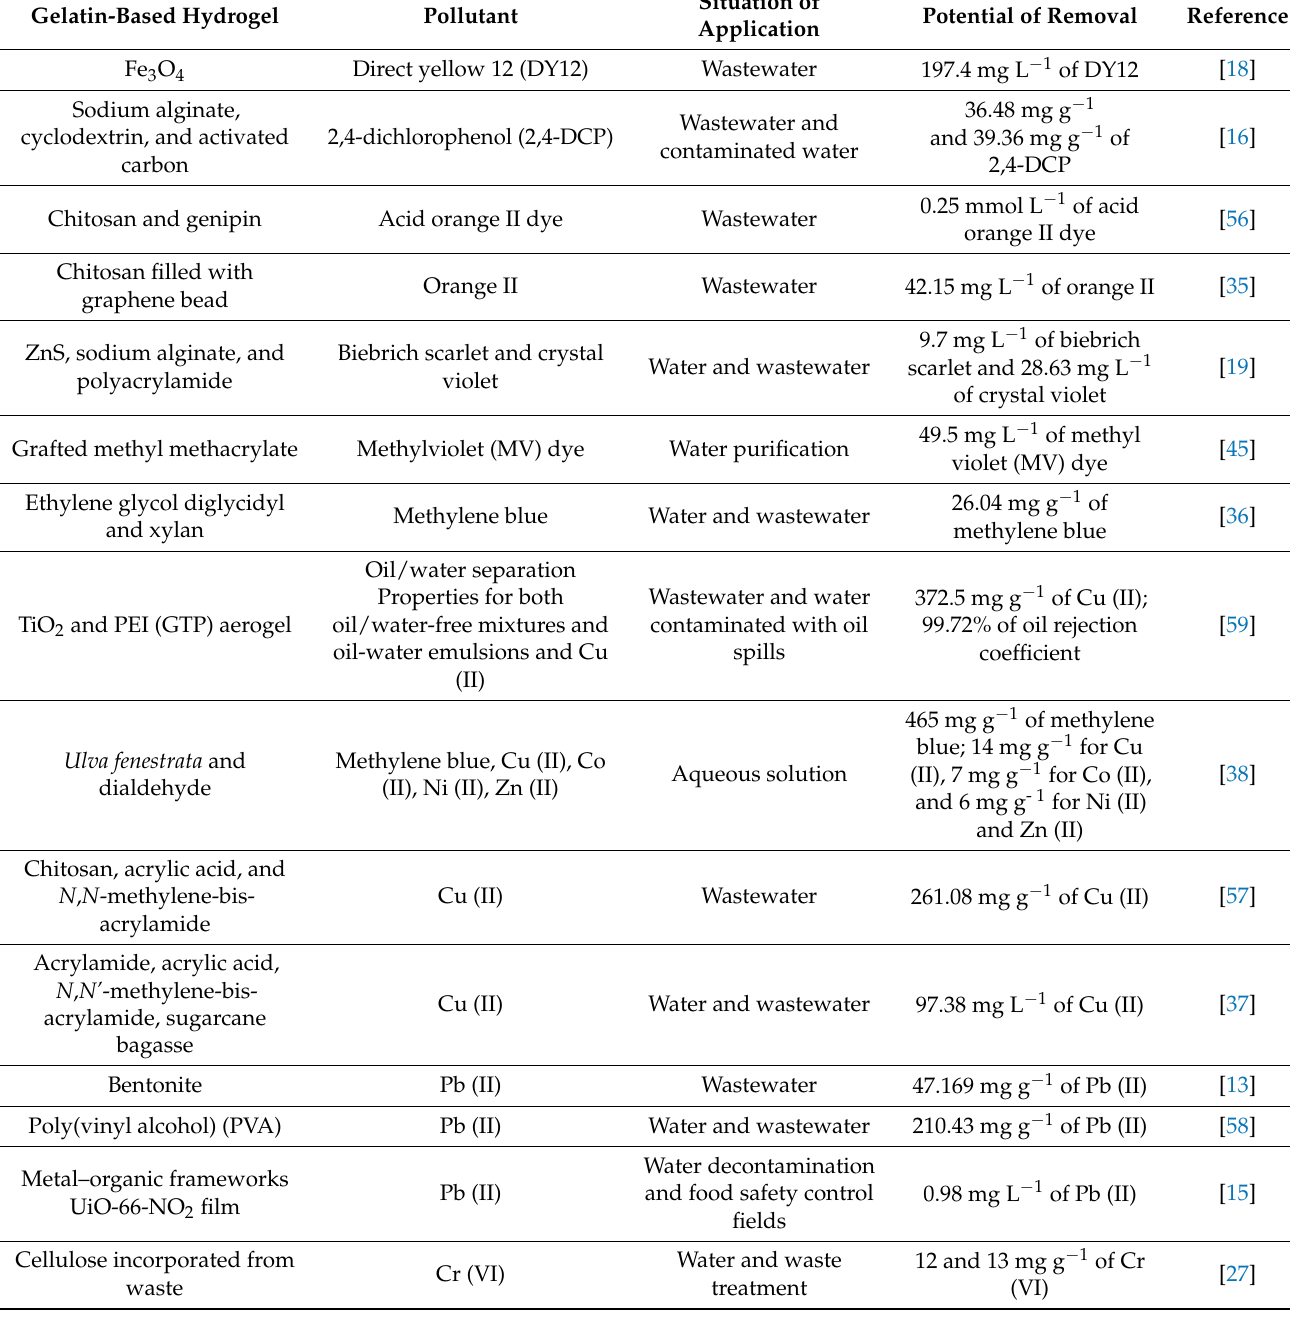
Table 3. Different compositions and uses of gelatin-based hydrogels for